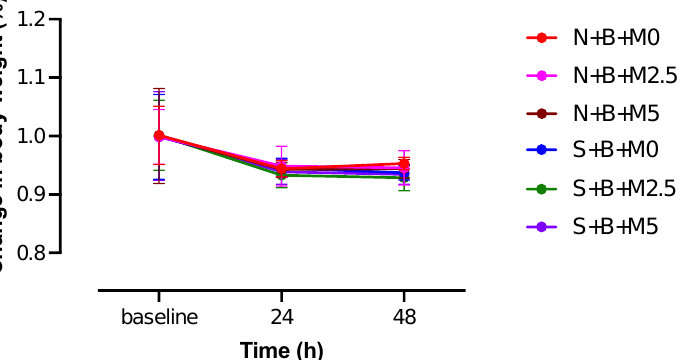
Figure 4. Comparison of post-treatment changes in body weight. Data are presented as mean ± SD. N + B + M0 group: n = 7; N + B + M2.5 group: n = 7; N + B + M5 group: n = 7; S + B + M0 group: n = 7; S + B + M2.5 group: n = 7; and S + B + M5 group: n = 7. Table 2. Comparison of nest consolidation scores before and after treatment. Data are presented as median (25–75% percentile). *, value significantly differs ( p < 0.03) between the N + B + M0 and N + B + M2.5 groups. †, value significantly differs ( p < 0.03) between the N + B + M0 and S + B + M5 groups. N + B + M0 group: n = 7; N + B + M2.5 group: n = 7; N + B + M5 group: n = 7; S + B + M0 group: n = 7; S + B + M2.5 group: n = 7; and S + B + M5 group: n =